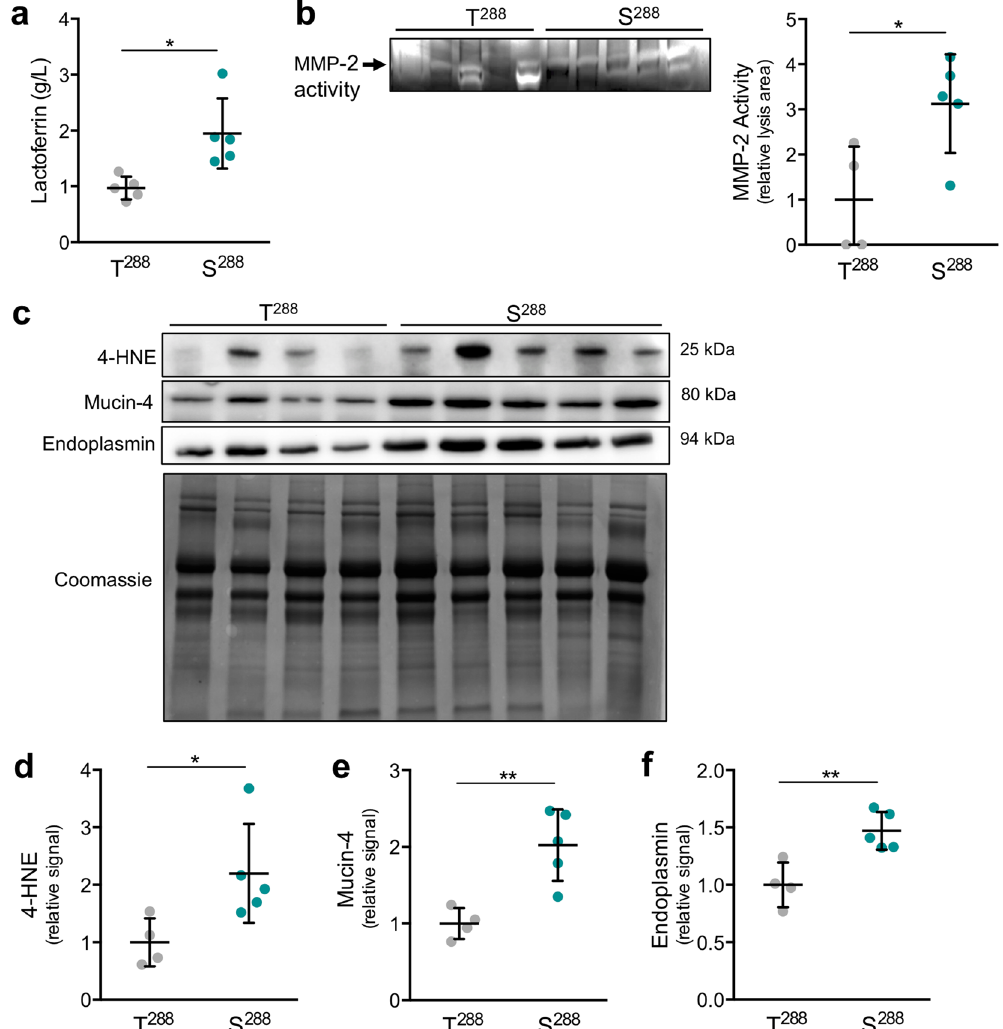
Figure 1. Markers of breast dysfunction and oxidative stress in breast milk from women harboring wild-type ZnT2 (T 288 ) or the ZnT2 variant (S 288 ). ( a ) Measurement of lactoferrin concentration in breast milk from women harboring two wild-type ZnT2 alleles (T 288 ) and women harboring the ZnT2 variant (S 288 ). Milk lactoferrin concentration was measured by ELISA. Data represent mean milk lactoferrin concentration (g/L) ± SD from n = 5 samples/genotype. ( b ) Evaluation of MMP-2 activity in breast milk from women harboring T 288 or S 288 . MMP-2 activity was determined by gelatin zymography (arrow); data represent mean gelatin lysis area (clear bands) relative to T 288 ± SD from n = 4–5 samples/genotype. Cropped gel is displayed and full-length gel can be found in Supplementary Fig. S2a. ( c ) Representative immunoblots of oxidative stress markers (4-HNE, mucin-4 and endoplasmin) in a fixed volume (5 µ L) of breast milk from women harboring T 288 or S 288 . A replicate gel was stained with Coomassie Blue as a loading control (bottom panel). Cropped blots are displayed and full-length blots can be found in Supplementary Fig. S2b–d. Quantification of relative protein abundance of ( d ) 4-HNE, ( e ) mucin-4 and ( f ) endoplasmin. Data represent mean signal intensity normalized to T 288 ± SD from n = 4–5 samples/genotype; p < 0.05 * , p < 0.01 **